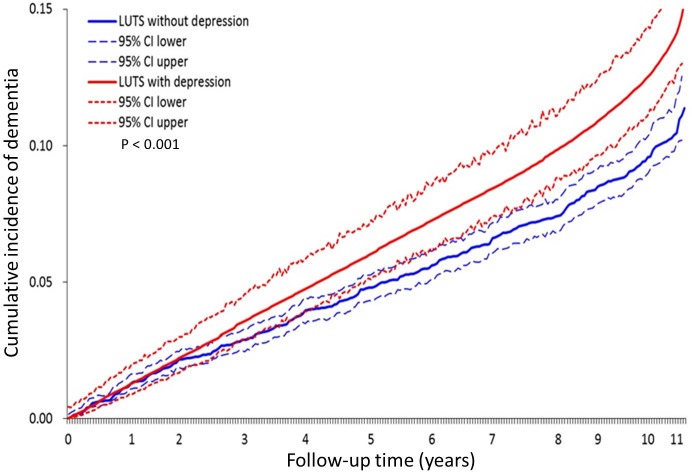
Difference of the cumulative incidence of dementia between patients with lower urinary tract symptoms (LUTS) with and without depression and 95% confidence band.P< 0.001.